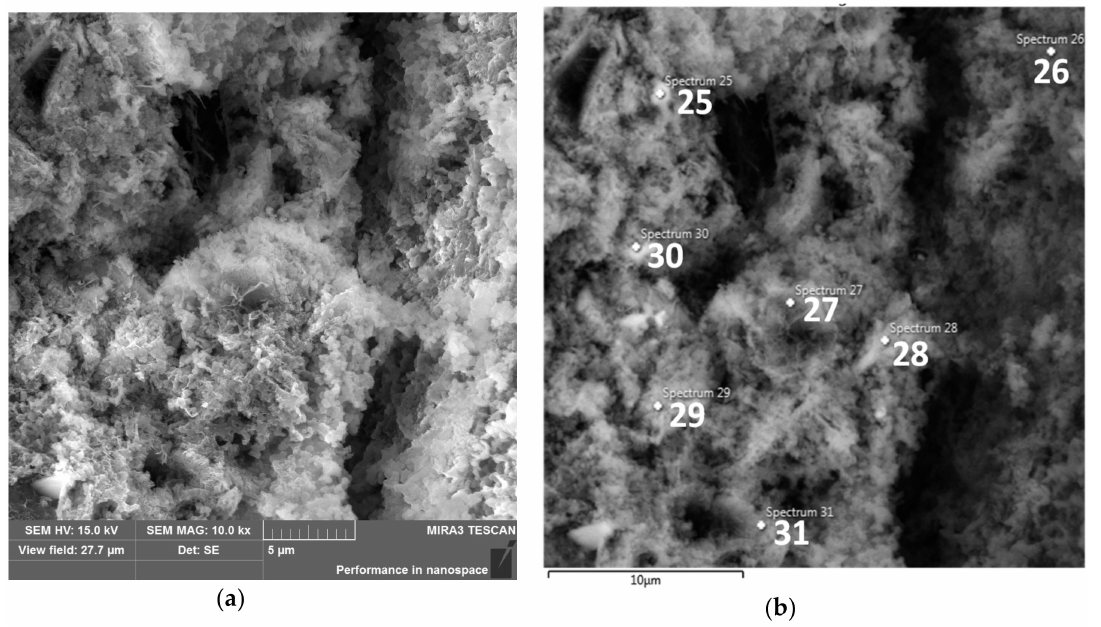
Figure 20. ( a ) SEM-SE image of M.6.1, mag.: 10k × . ( b ) SEM-SE image of M.6.1, mag.: 10k × . Points